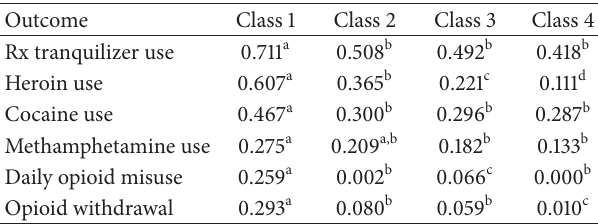
Table3:Probabilitiesofengaginginorexperiencingrecent(30-day) drug use outcomes based on prescription opioid misuse